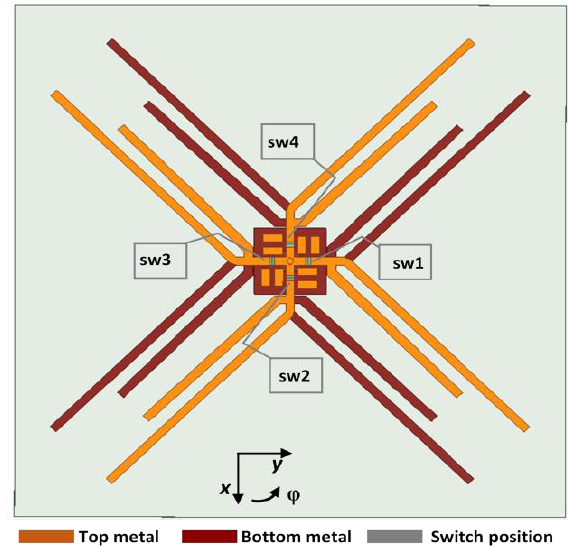
Figure 1: Geometry of the